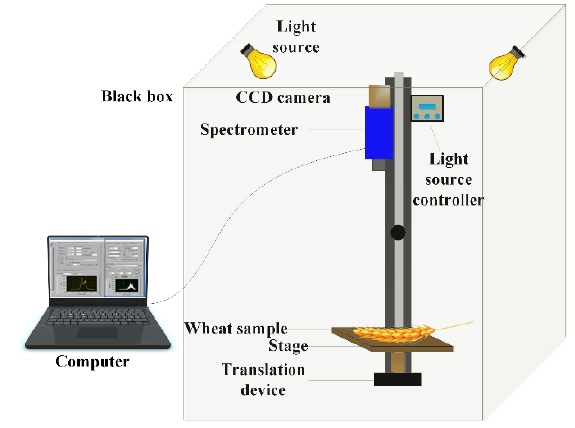
Figure 2. Hyperspectral imaging system.